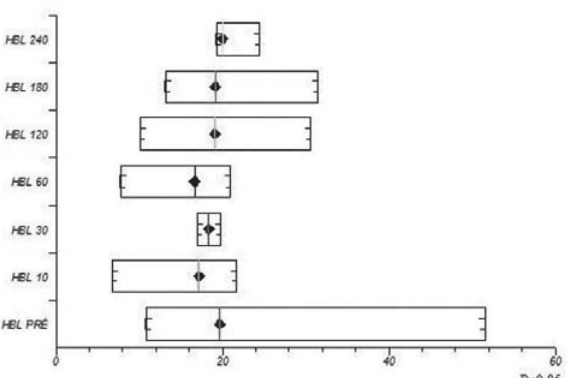
Fig. 2 – Taxa de transferência de dióxido de carbono (TTCO relação aos tempos de circulação extracorpórea